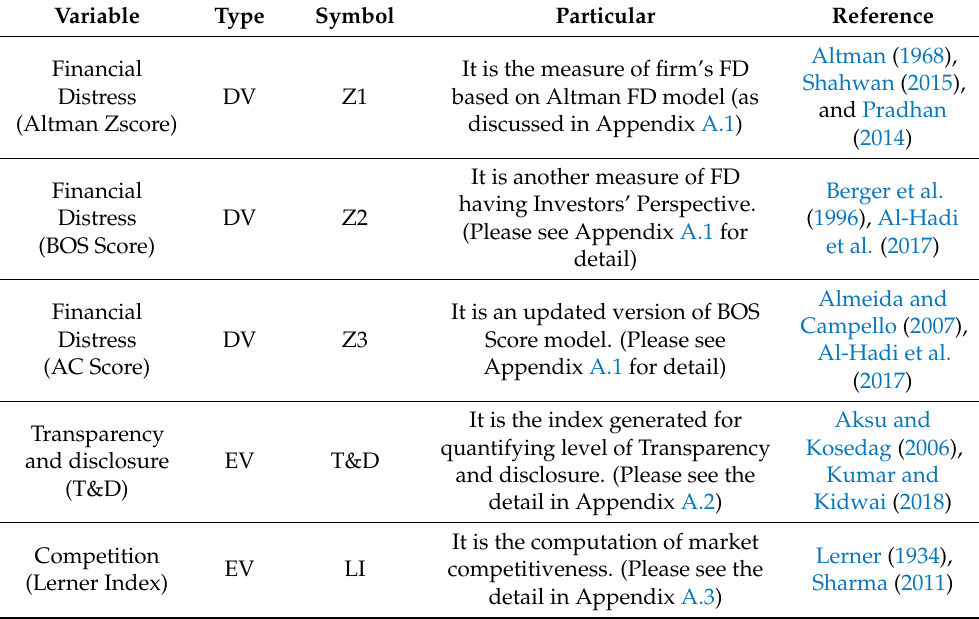
Table 1. List of